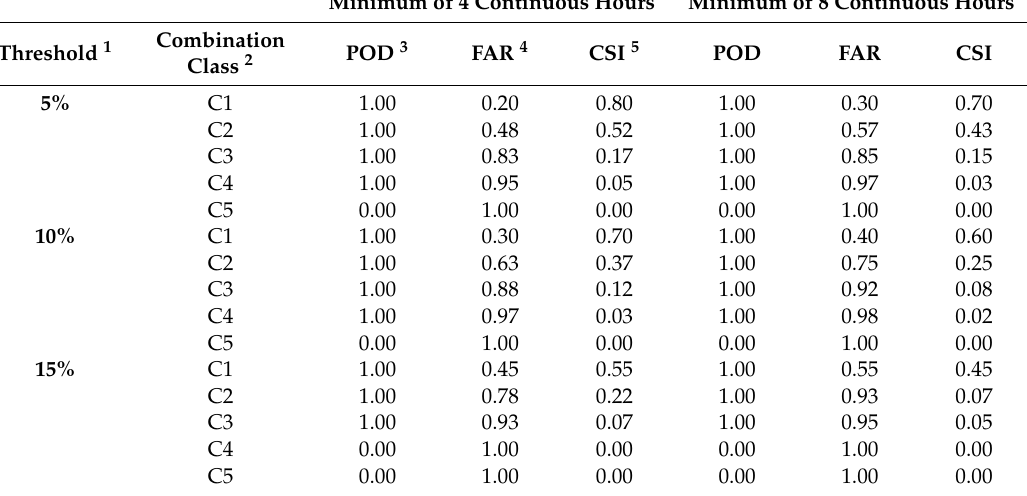
Table 3. Model calibration: statistical contingency scores for di ff erent classes of combined weather variables according to defined thresholds. These thresholds correspond the frequencies over a week during the March–May period. All combinations of weather variables included rain ≤ 0.1 mm. Data for occurrence of wheat stripe rust (WSR) for six study sites (Ain Jem â a, Ain Orma, Ain Taoujdate, Boufekrane, El Hajeb, and M’Haya) were